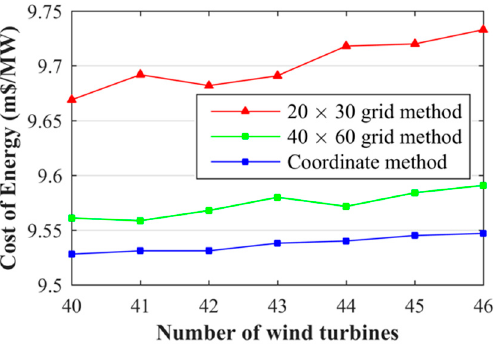
Figure 4. Wind farm cost of energy results (in million dollars per megawatt) for different design methods.